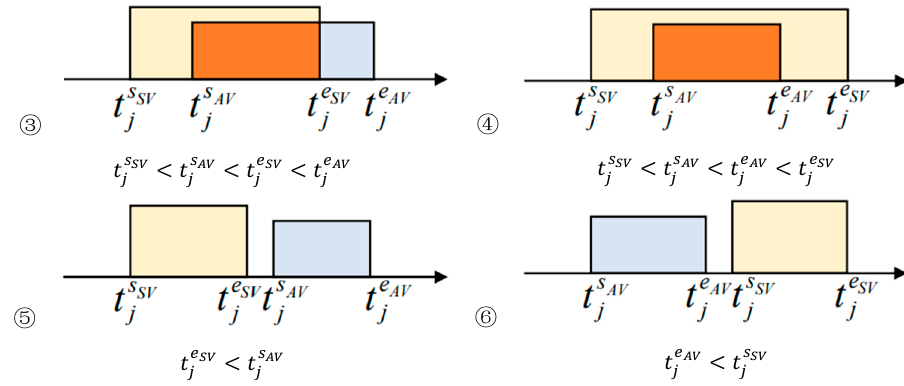
Figure 5. Classification of TTE sequence arrangement in the collision Figure 5. Classi fi cation of TTE sequence arrangement in the collision area.